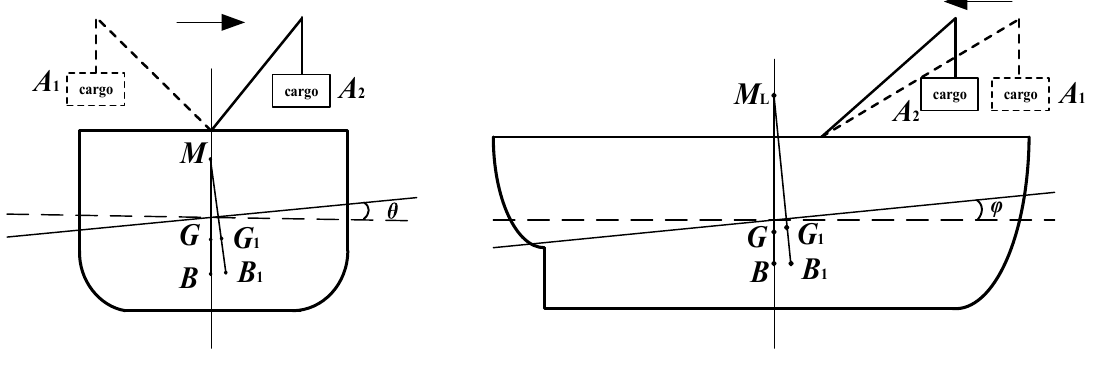
Figure 2. Rotating operation process of the RFC.